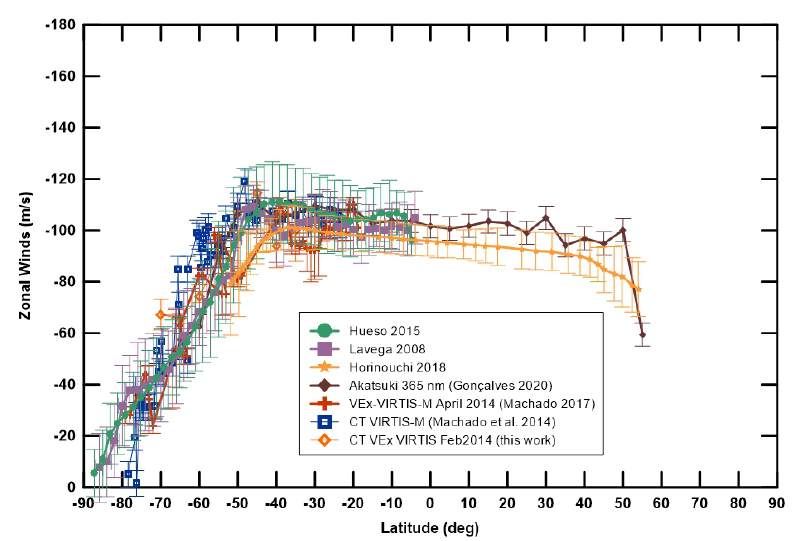
Figure 7. Comparison between this work’s mean zonal wind latitudinal profile (VEx VIRTIS-M at 380 nm) with other previous space-based long-term precedent results using the same instrument and wavelength images [4,6,19,21], as well as the results from Akatsuki/UVI at 365 nm